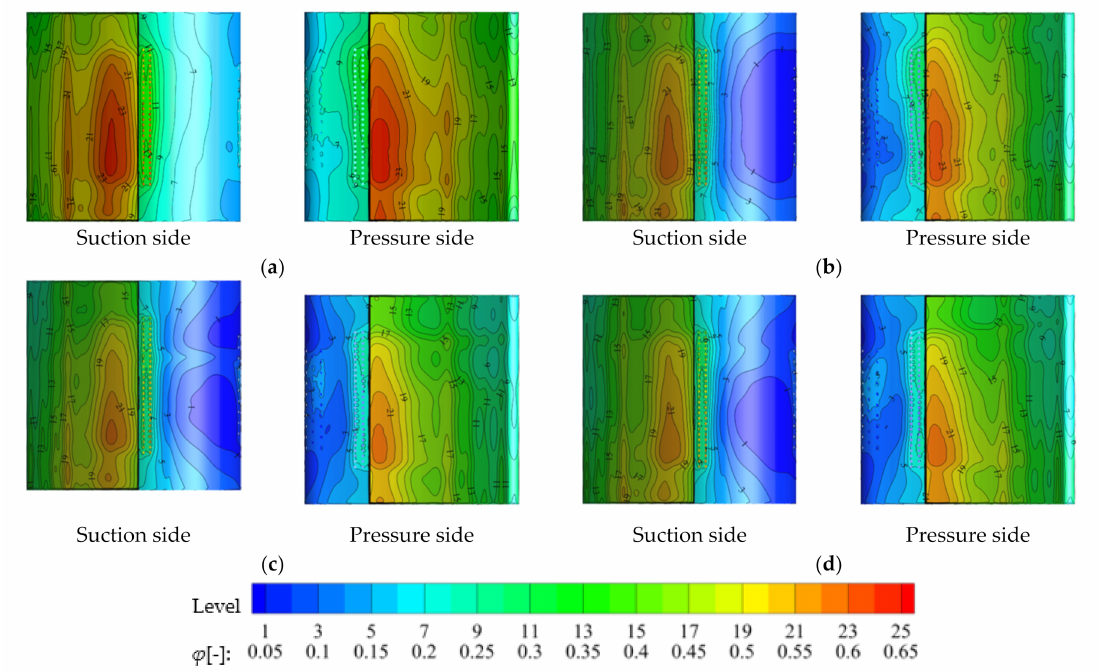
Figure 12. Overall cooling effectiveness distribution for different cases. ( a ) Case 1: uniform inlet; ( b ) Case 2: HS only; ( c ) Case 3: HS and PSW; ( d ) Case 4: HS and